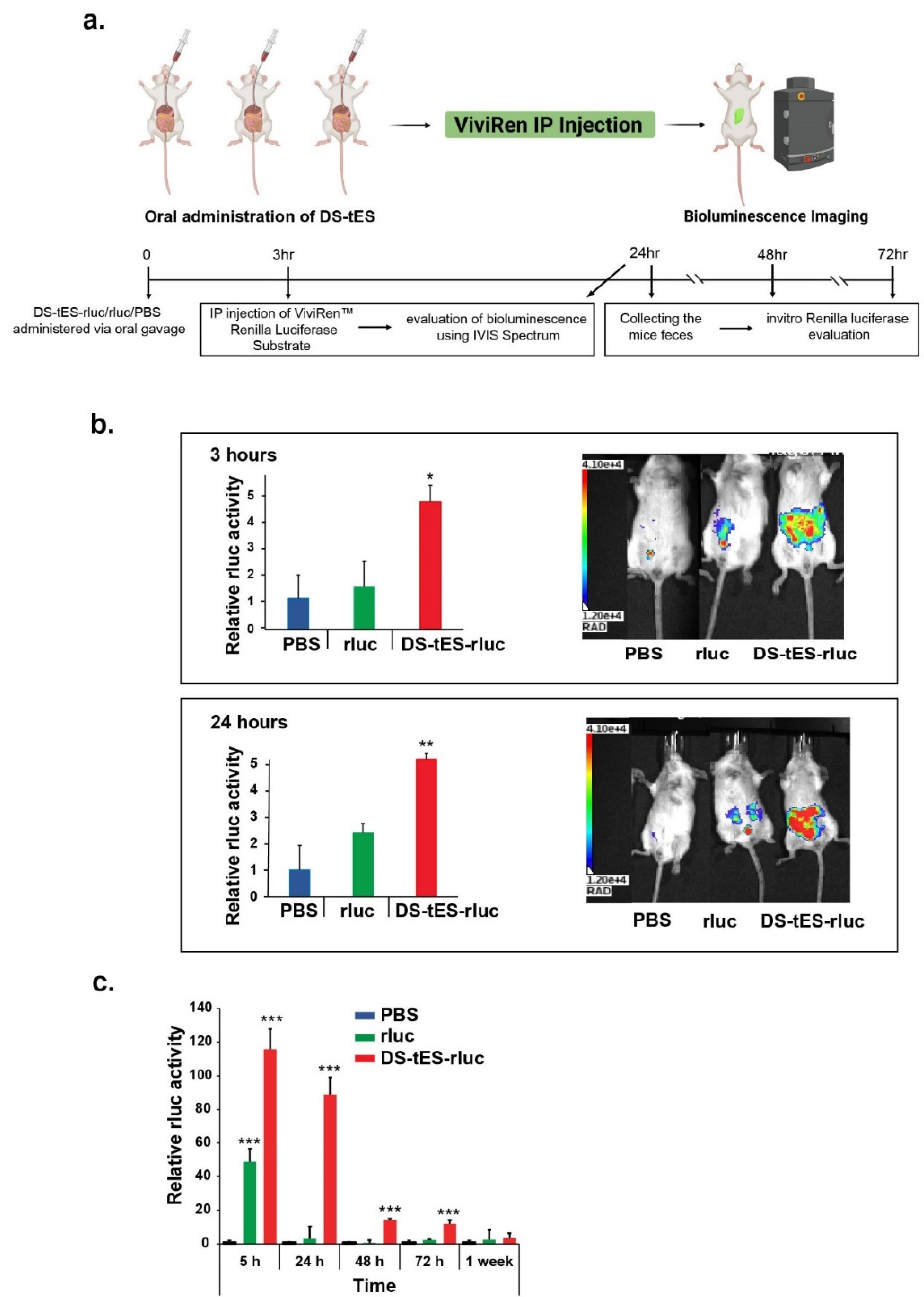
Figure 4. ( a ) Schematic representation of oral administration of DS-tES-rluc/rluc followed by IP injection of ViviRen substrate. ( b ) Bioluminescence emitted from mice administered with DS-tES-rluc/rluc in 3 and 24 h. ( c ) Luciferase activity measurement from mice fecal matter for up to 1 week. (( b , c ): data are shown as mean ± SEM, n = 4. *** p < 0.001, ** p < 0.01, * p < 0.05).